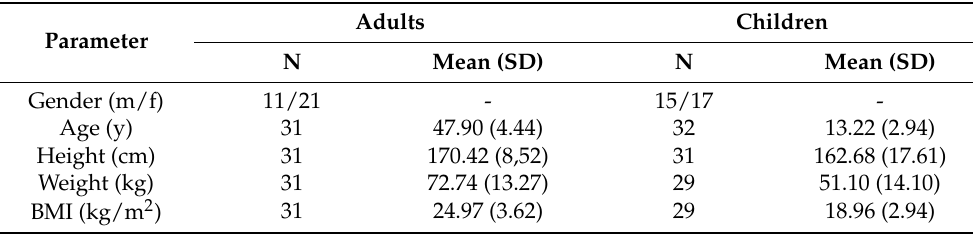
Table 1. Characteristics of the participants. Displayed are the number of participants (N), means, and standard deviations (SD) for the parameters gender (male/female), age in years (y), height in centimeter (cm), and weight in kilogram